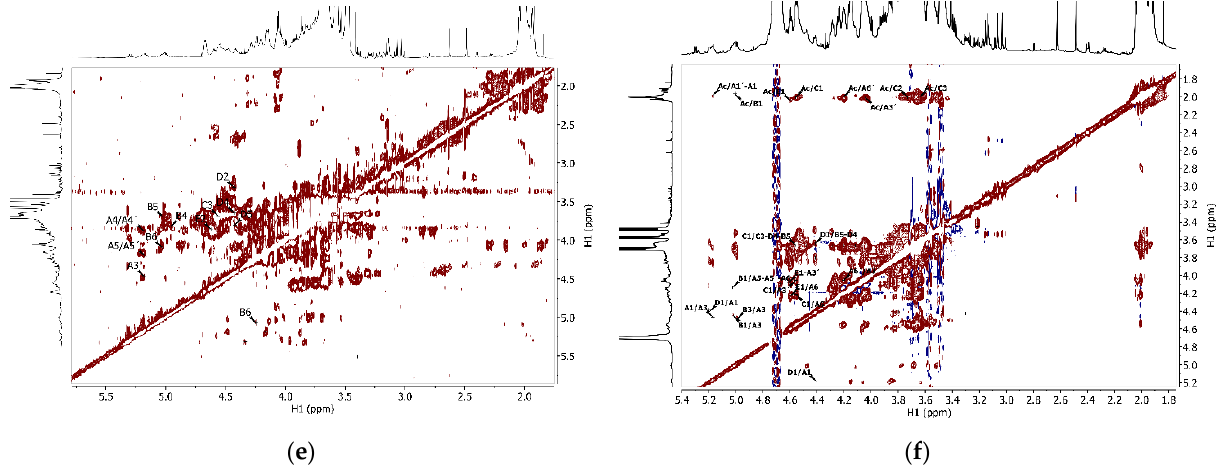
Figure 6. ( a ) DOSY, ( b ) 1 H NMR (diffusion filter applied), ( c ) 1 H ‐ 13 C HSQC, ( d ) 1 H ‐ 1 H COSY, ( e ) 1 H ‐ 1 H TOCSY, and ( f ) 1 H ‐ 1 H NOESY for polysaccharides from the tunic.